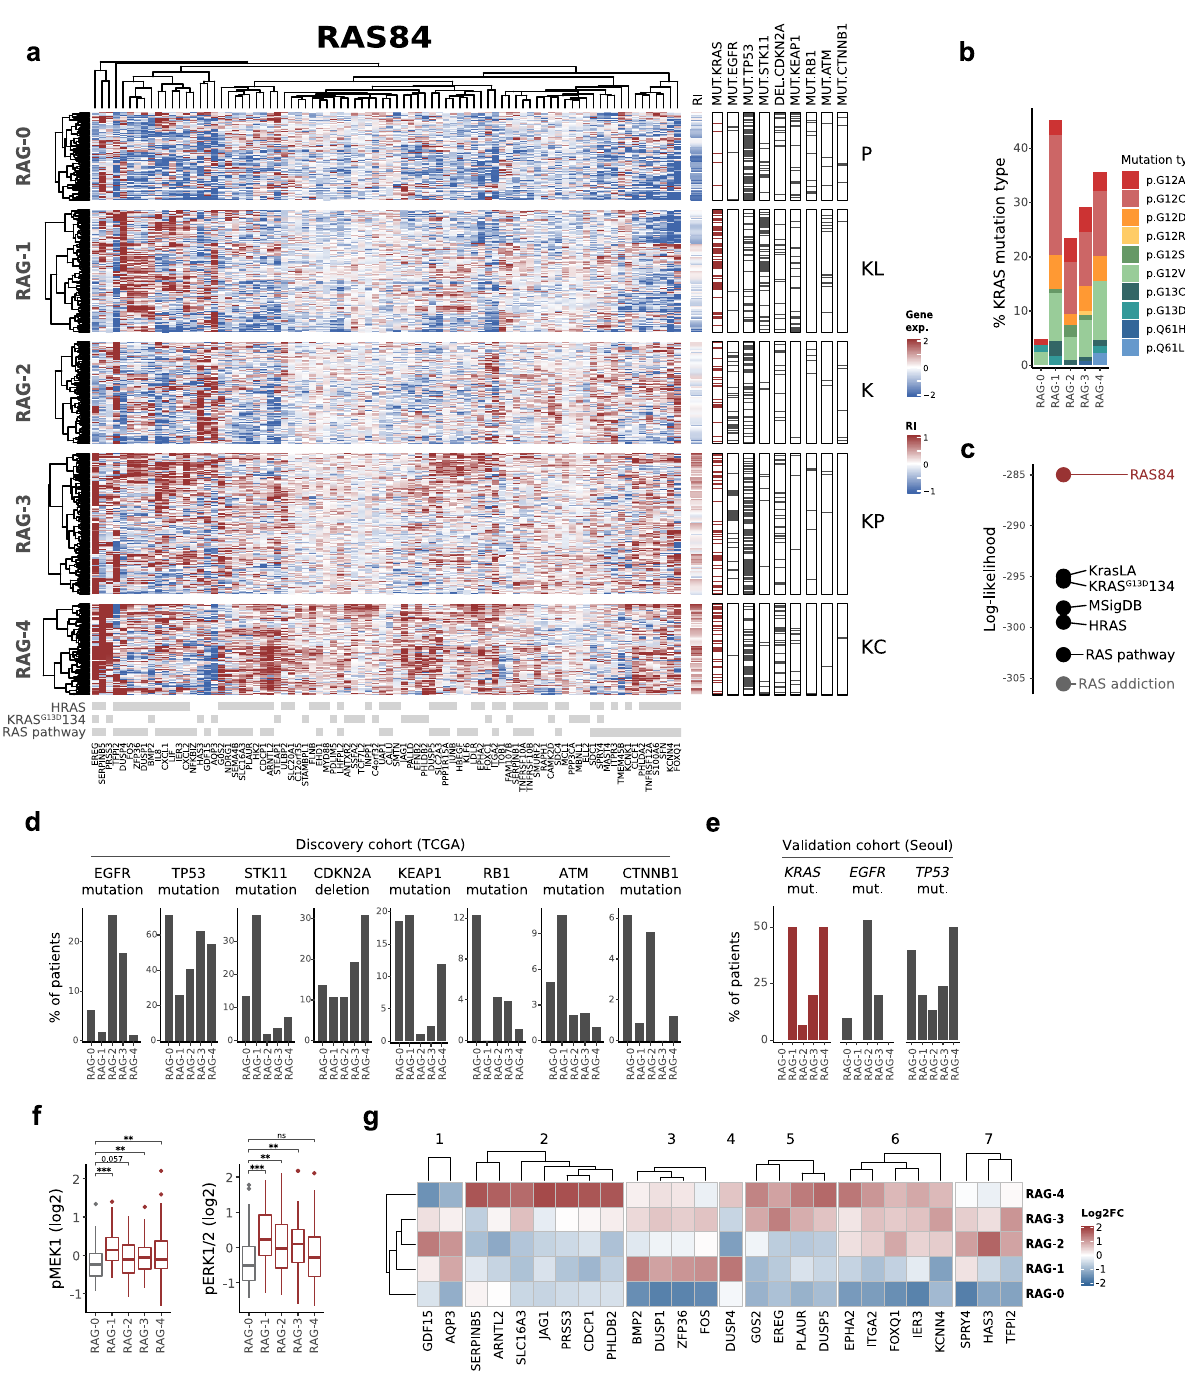
Fig.3|LUADclassi fi cationbyRAS84.a HeatmapshowingclusteredRAS84genes and TCGA LUAD cohort patients. Patients are shown as rows, genes as columns. Patients have been clustered into fi ve RAS activity groups (RAGs) by hierarchical clustering using a ward.D2 agglomeration method. Aggregate RAS84-Index (RI) scores are shown to the right of the main heatmap. Genome variants with a sig- ni fi cantnon-randomdistributionacrosstheRAGsareshownintheninecolumnson the right (chi-square fdr < 0.05). These mutations are used to characterise the fi ve clustersshown by the labelson the right (P, TP53; KL, KRAS/LKB1(STK11);K,KRAS; KP, KRAS/TP53; KC, KRAS/CDKN2A). KRAS mutants are shown in dark red. Parent signature membership is shown in grey at the bottom of the heatmap. b The per- centageofKRASmutations perRAGbrokendownbyspeci fi c KRASmutation type. c Log-likelihood values from a GLM fi t (family=binomial) of KRASmutation status